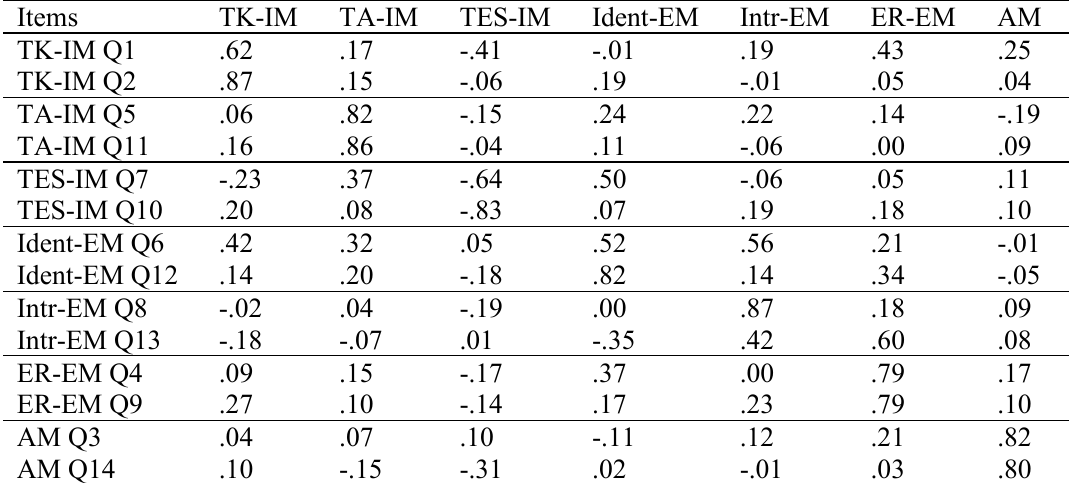
Table 4. Factor loadings for principal components factor analysis with direct oblimin rotation of items of the